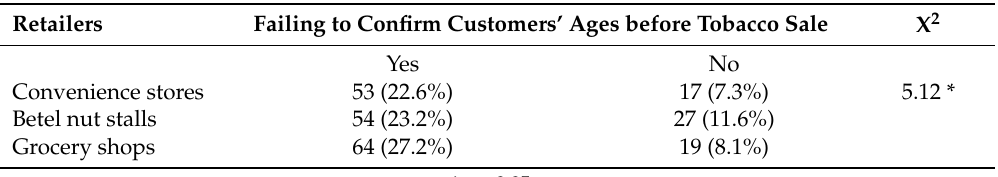
Table 1. Failing to confirm customer ages when selling tobacco products prior to the counseling strategies being supplied (n =